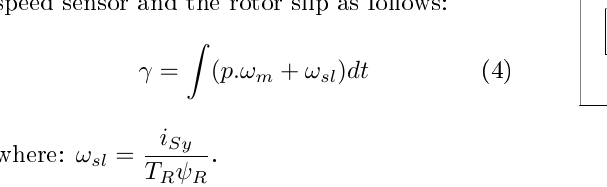
Fig. 2. Block diagram of the HPWM technique with current sensors. Fig. 2: Block diagram of the HPWM technique with JOURNAL OF ADVANCED ENGINEERING AND COMPUTATION http://dx.doi.org/... current sensors. VOL. 0, NO. 0, 0-0, DEC. 0000